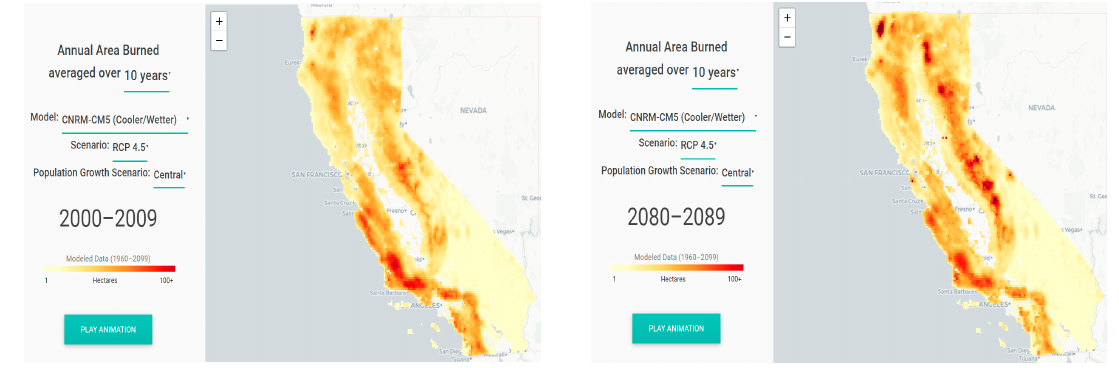
Figure 1. Annual areas burned—this decade versus the future (State of California).